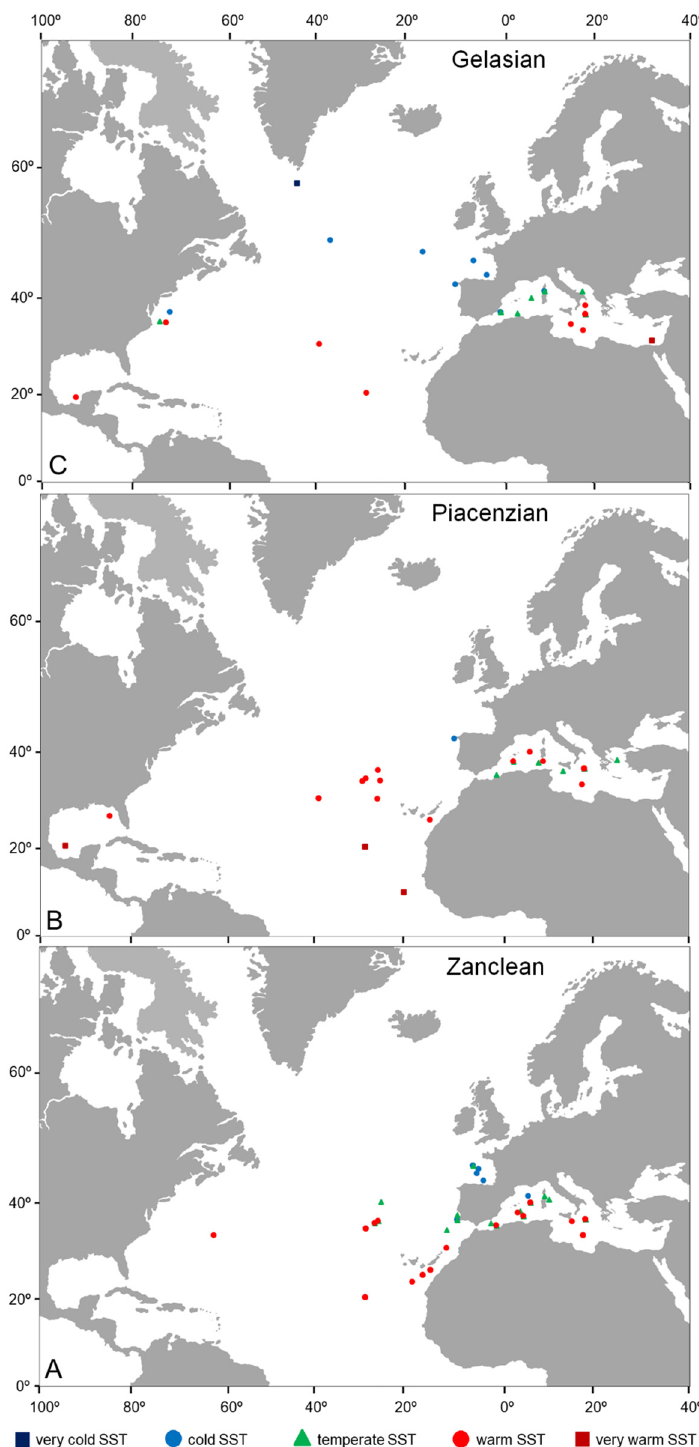
Figure 8. Location of the closest modern analogs to the Pliocene–Gelasian samples of the ODP-site 975. ( A ) Zanclean; ( B ) Piacenzian; ( C ) Gelasian .